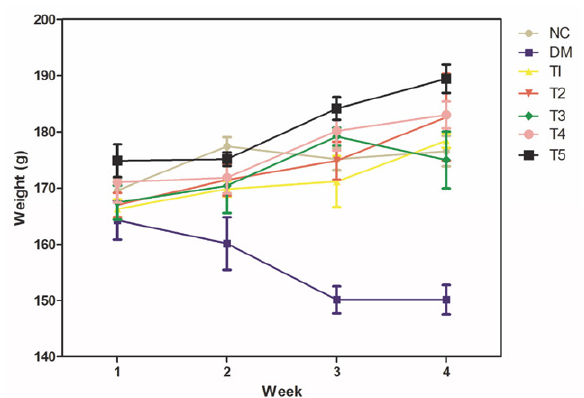
Fig. 1 . Effect of treatment on Total Body Weight of Rats. NC – nor- mal control group, DM – diabetic control group, T1 – E. chlorantha treated group, T2 - Metformin treated group, T3 - E. chlorantha + lisinopril treated group, T4 - Metformin + lisinopril treated group and T5 – Lisinopril treated group.